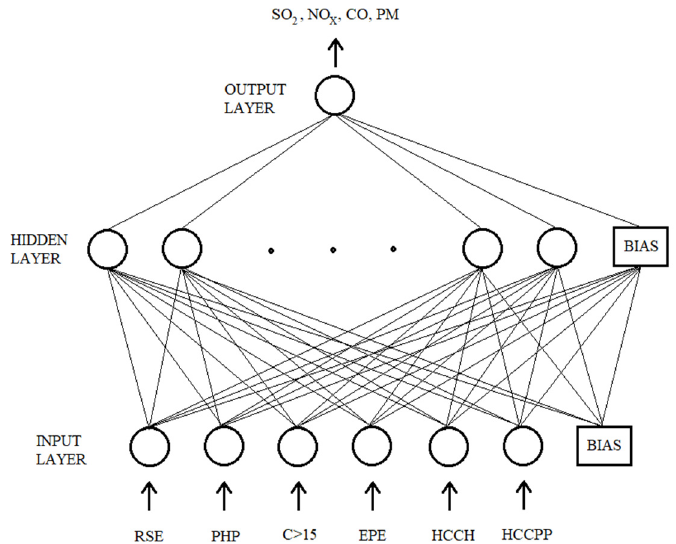
Figure 5. MLP neural ‐ network architecture.